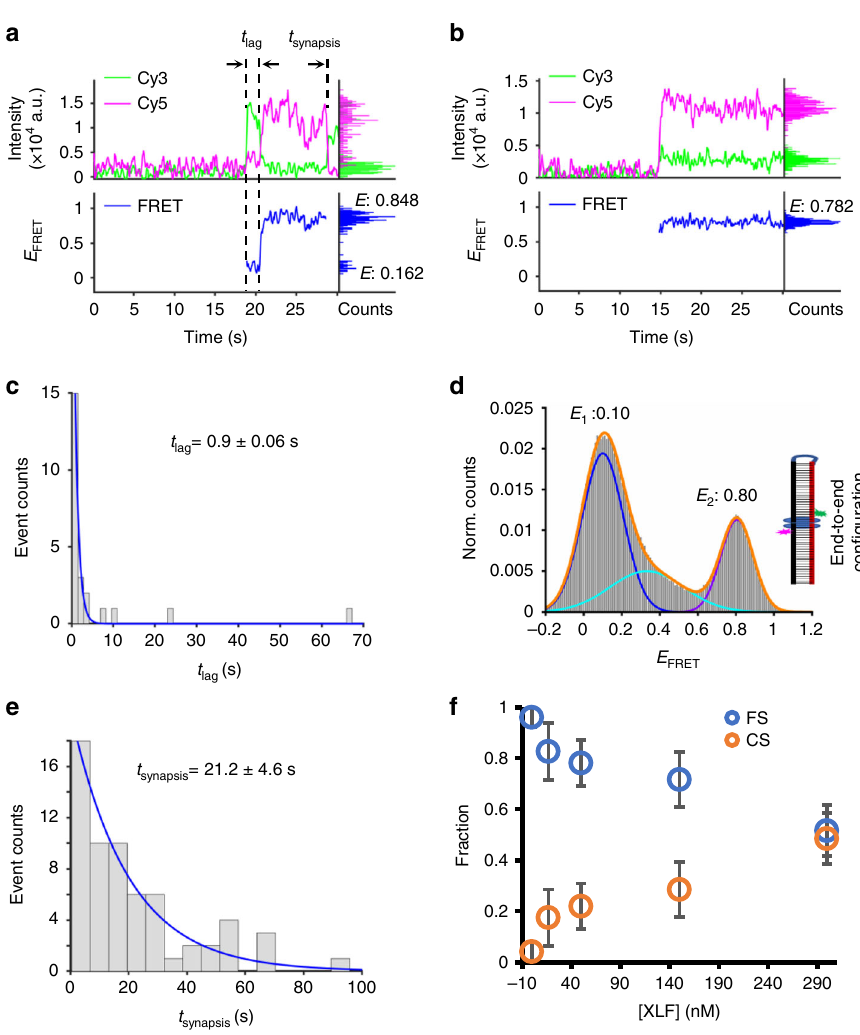
Fig. 3 XLF increases end proximity of dsDNA within synaptic complexes. a , b Representative single-molecule time traces of donor (green) intensity, acceptor (magenta) intensity, and corresponding E FRET values (blue) for synapsis mediated by 25 nM Ku, 50 nM X4L4, and 50 nM XLF. The right parts are histograms of donor intensity (green), acceptor intensity (magenta), and E FRET values (blue) within synapsis period. c Histogram and corresponding exponential fi t of lag time between synapsis starting and transition to high E FRET . Only the events with a detectable transition from low E FRET ( E < 0.6) to high E FRET ( E ≥ 0.6) were included. n = 23 traces. Error represents the SEM of the fi t. d Histogram of E FRET values of all synapsis events mediated by Ku, X4L4, and XLF. The E value shown was obtained from a Gaussian fi t of the highest peak of each kind of synaptic complex ( FS or CS ). n = 423 molecules. The diagram illustrates an end-to-end con fi guration of the CS state which is ready for ligation. e Histogram and corresponding exponential fi t of synapsis time of high E FRET ( E ≥ 0.6) events mediated by Ku, X4L4, and XLF. Only the high E FRET events ( n = 63) with both start and end time points within the detection time window were included. Error represents the SD of two independent replicates. f XLF concentration-dependent synaptic complex formation. The reaction contains 25 nM Ku, 50 nM X4L4, and varied XLF. FS complex: E FRET < 0.6, CS complex: E FRET ≥ 0.6. Data are represented as mean ± SD of three independent replicates. Source data are provided as a Source Data1 fi